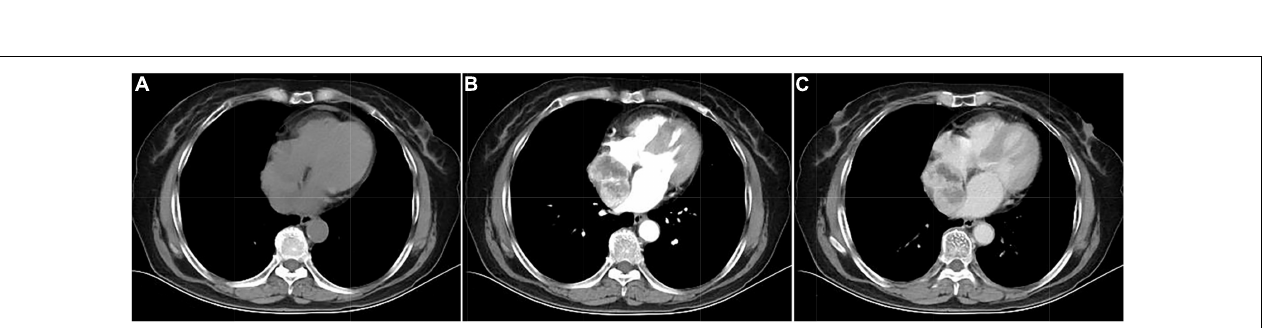
FIGURE 1 | Echocardiography of cardiac paraganglioma. An enlarged left atrium and a hypoechoic mass of about 4.6 cm × 4.6 cm at the top of the right atrium near the superior vena cava was found with clear borders and uniform internal echogenicity, as well as the compression of the right atrium and the superior vena cava.